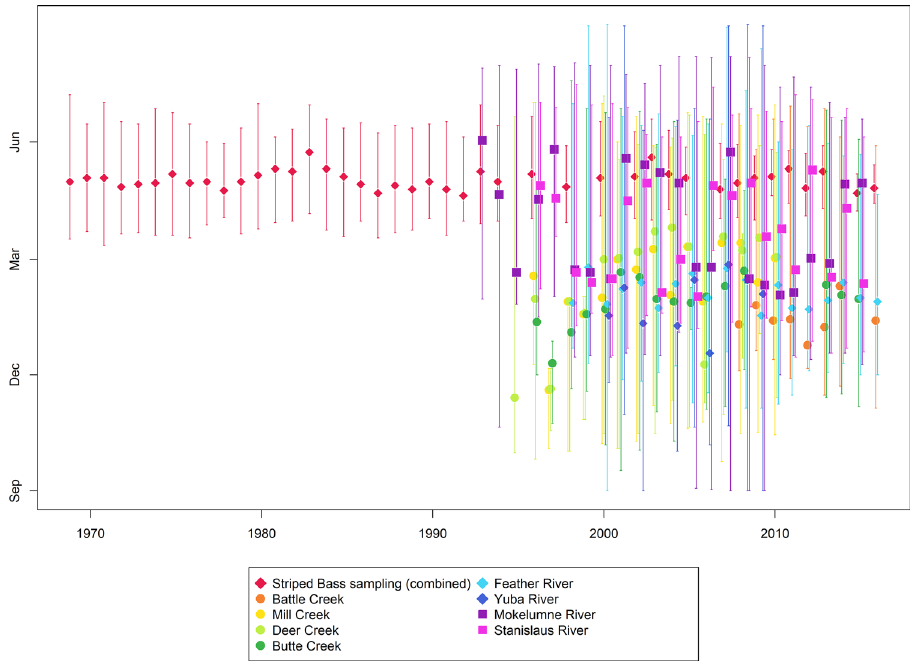
Figure 1. Median migration date for Striped bass and juvenile Chinook salmon. Each species and location sampled is denoted by color, with like areas of juvenile Chinook sampling grouped by symbol: circles for upper tributaries of the Sacramento River, diamonds for locations within the Feather River watershed, and square for watersheds that are not tributaries of the Sacramento River. Median date is represented by a single point and sampling period is represented by a vertical line through that point. The y-axis is September 1st to August 31st.